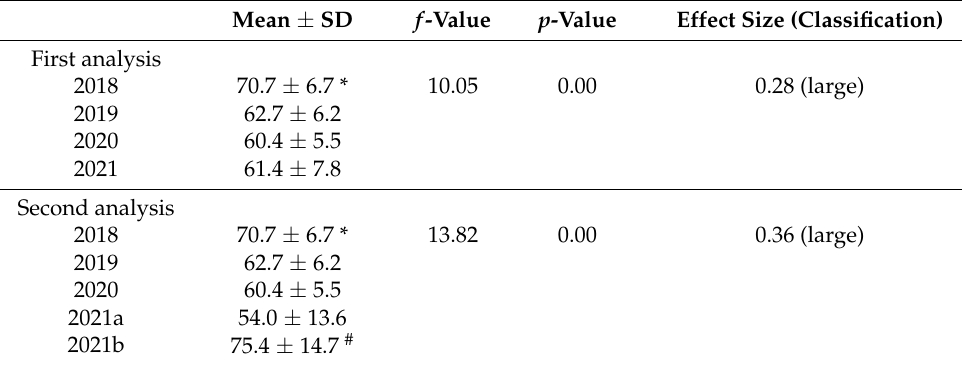
Table 1. Comparison of the home advantage between the last four seasons of the Brazilian Serie A championship. Mean ± SD f -Value p -Value Effect Size (Classification)